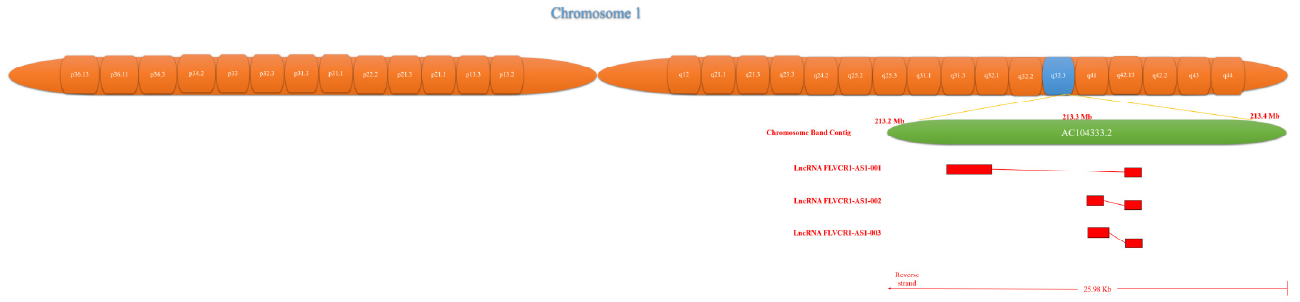
Figure 1. Genomic location of FLVCR1-AS1. LncRNA may contribute to disease progression by splicing regulation. FLVCR1-AS1 gene has six splice variants (http://grch37.ensembl.org/Homo_sapiens/Gene/Summary? g=ENSG00000198468;r=1:213025450-213031430, accessed on 30 October 2022). In addition, According to the lncLocator database